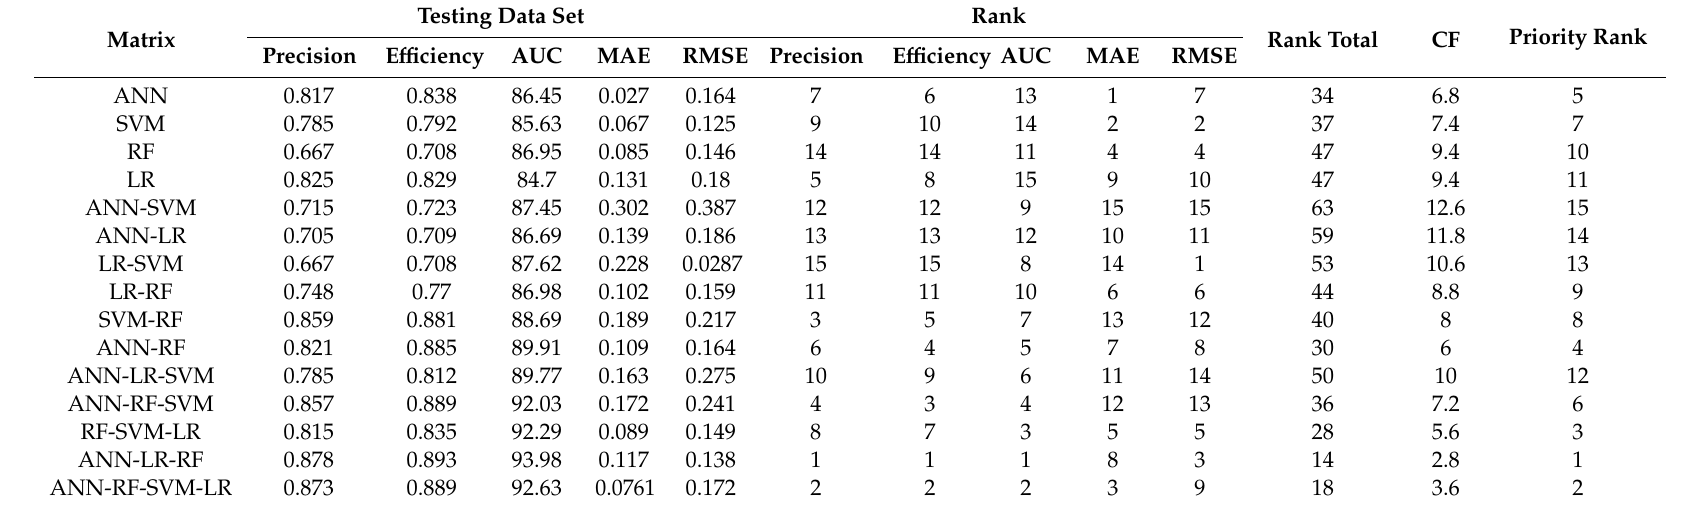
Table 5. Results of validation techniques and accuracy prioritization based on testing